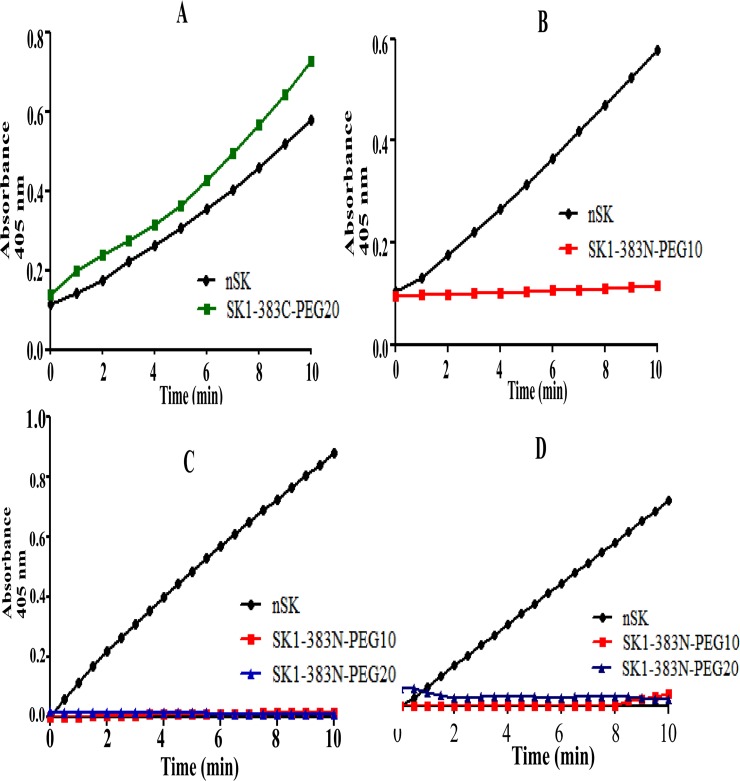
Amidolytic activity of nSK/truncated PEG-SK complexes with HPG/μPG at 37°C and 4°C.Pre-incubated HPG/uPG with nSK/truncated PEG-SK derivatives were added into the cuvette containing chromozyme ® PL. Amidolytic activity generation were monitored by change in absorbance at A405 by hydrolysis of the substrate S-2251. (A) Graph displays amidolytic activation by native SK (black circles) and SK1-383C-PEG20 (green rectangles) in complex with μPG at 37°C. (B) Graph depicts the effect of conjugation of PEG moiety at N-terminal of derivative SK1-383N-PEG10 (red rectangles) by blocking its amidolytic activation in comparison with nSK (black circles), after making complex with μPG, at 37°C. (C) Graph displays the blocking of pathway I by N-terminally PEGylated SK truncated derivatives i.e. SK1-383N-PEG10 (red rectangles), SK1-383N-PEG20 (blue triangles) in comparison with nSK (black circles), when in complex with uPG, at 4°C. (D) Graph depicts no amidolytic activation by SK1-383N-PEG10 (red rectangles) and SK1-383N-PEG20 (blue triangles) in comparison with nSK (black circles), after making 1:1 complex with HPG, at 4°C. Statistical analysis showed significant difference (p-value < 0.0001, n = 6, one-way ANOVA test).